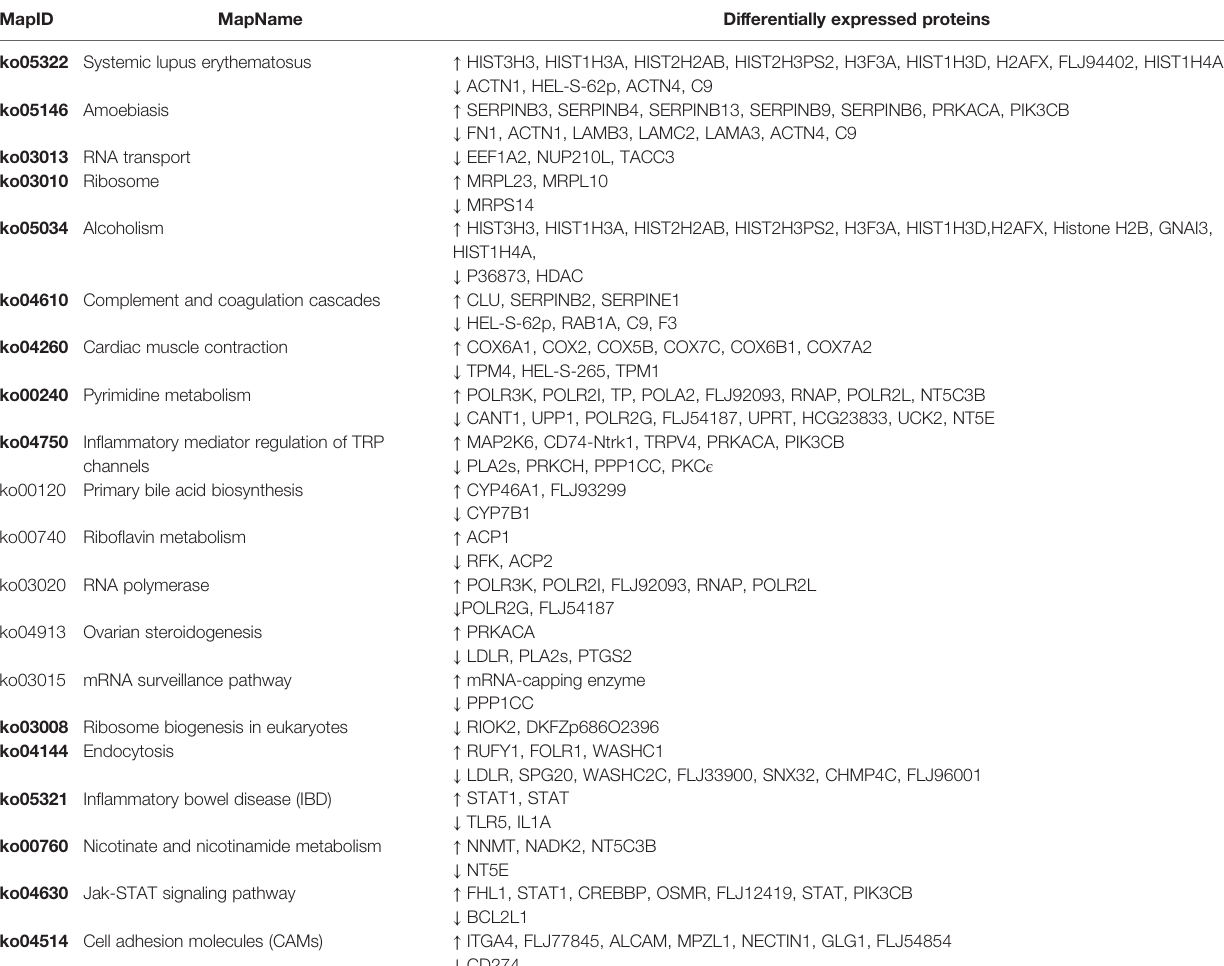
TABLE 3 | Top 20 enriched KEGG pathways among the differentially expressed proteins. MapID MapName Differentially expressed proteins ko05322 Systemic lupus